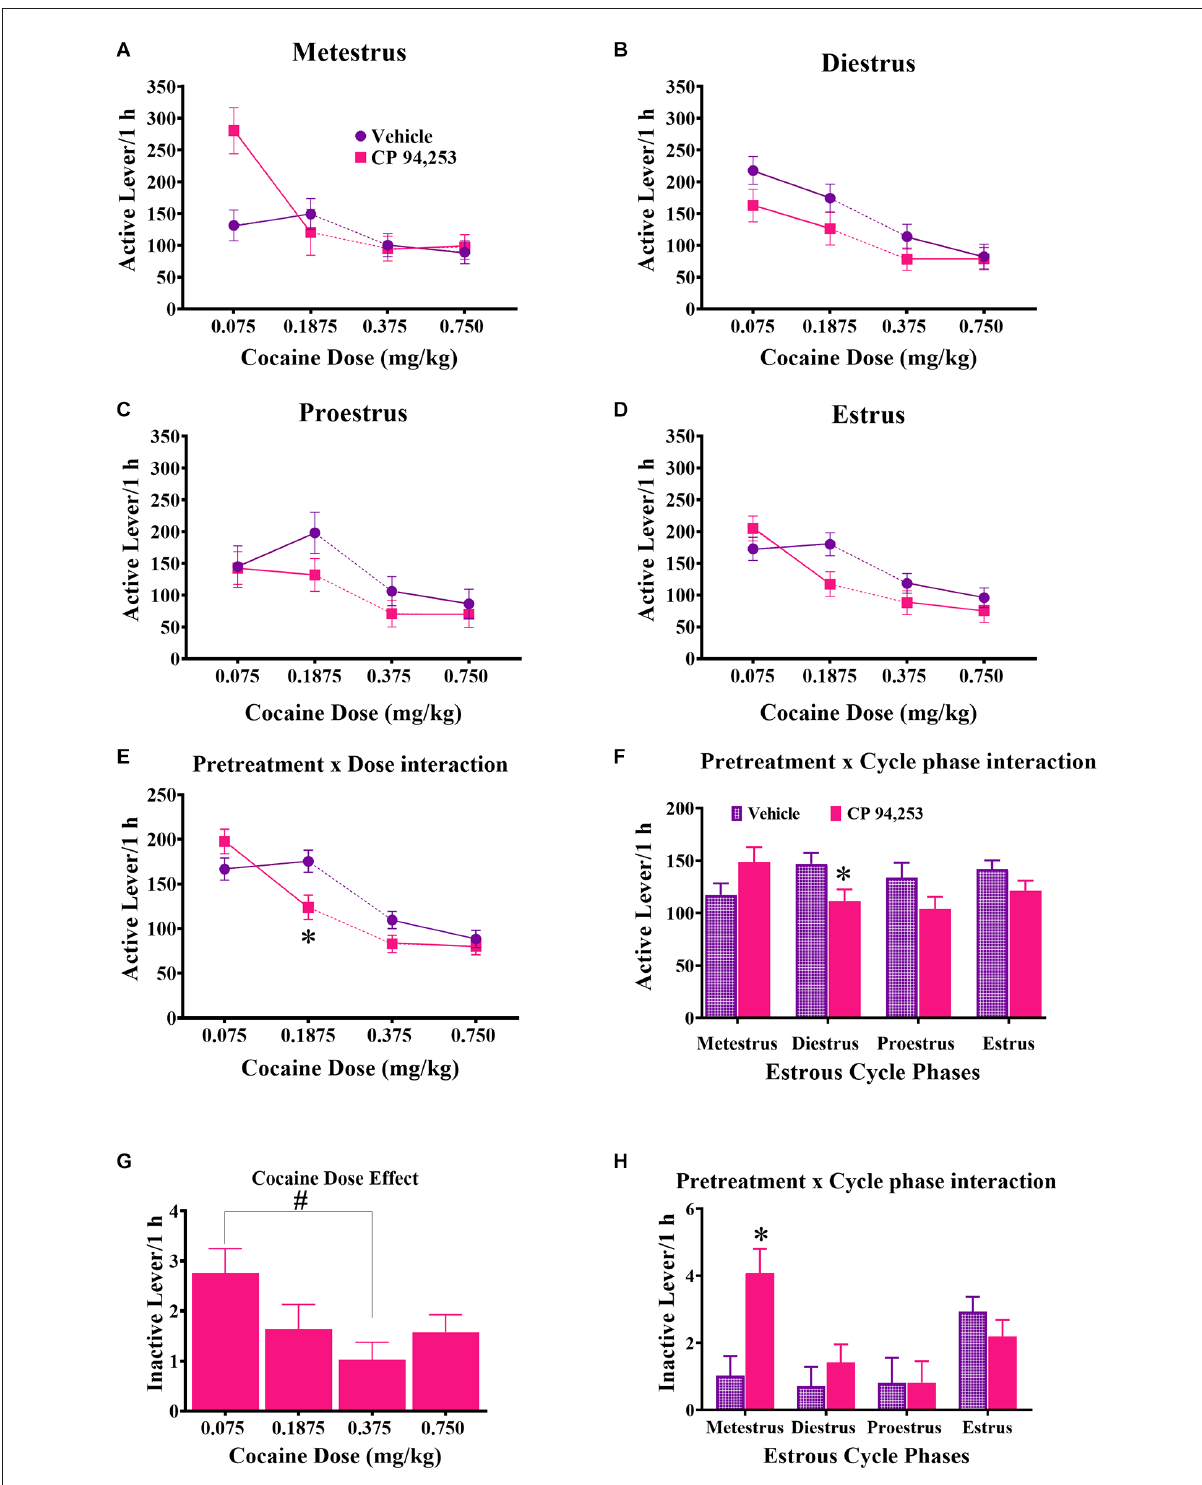
FIGURE4 EffectsofCP94253onmean ± SEMactiveleverresponserates (A–F) andinactiveleverresponserates (G,H) underanFR5reinforcementschedule in female rats during each estrous cycle phase (A–D) and ANOVA interactions between pretreatment and dose (E) and pretreatment and cycle phase (F) for active lever responses and the main effect of dose (G) and pretreatment by cycle phase interaction (H) for inactive lever responses. For experimental details and n/condition see text or Figure 1 caption. ∗ Difference from vehicle pretreatment, Bonferroni t -tests, p < 0.0167; # difference between 0.075 and 0.375 mg/kg cocaine, Bonferroni t -tests, p <